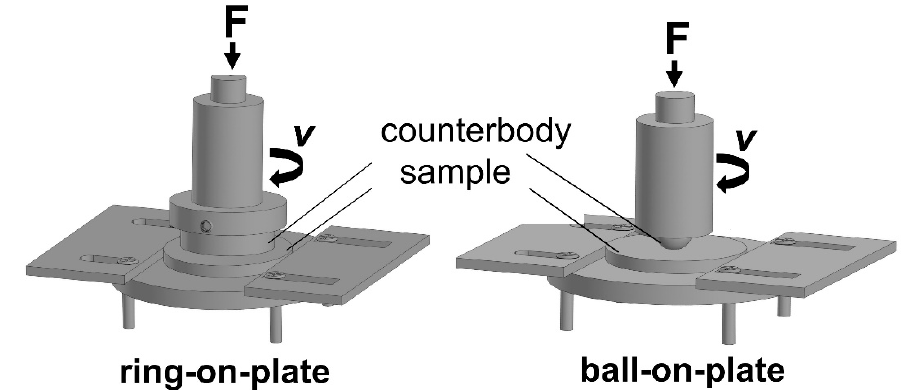
Figure 3. Schemes of the wear test.